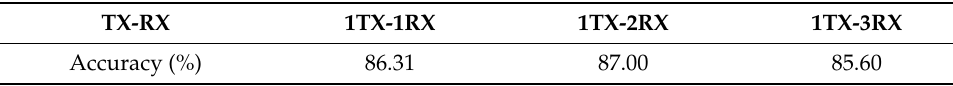
Table 6. The accuracy for different TX-RX antenna pairs.